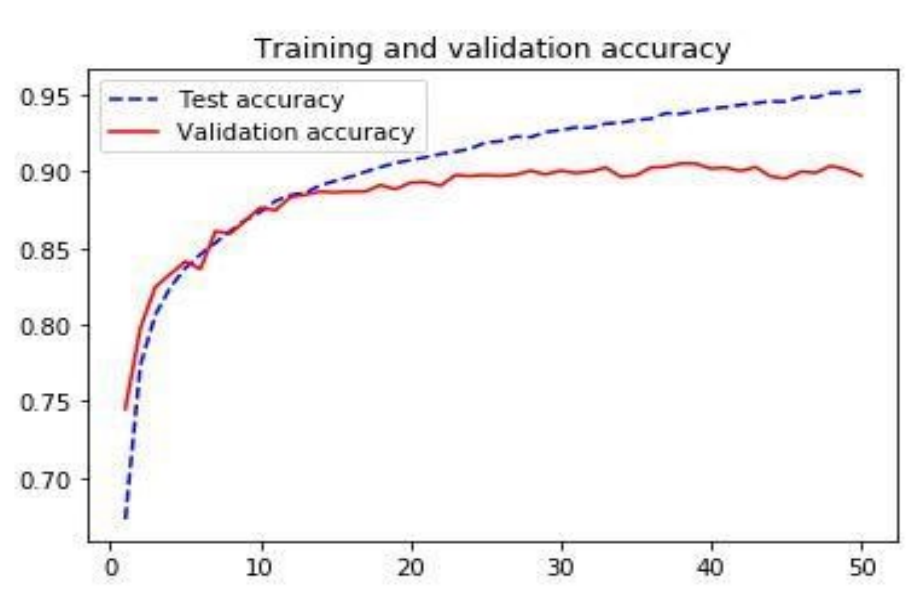
Figure 3. CNN-Training and Validation Accuracy.